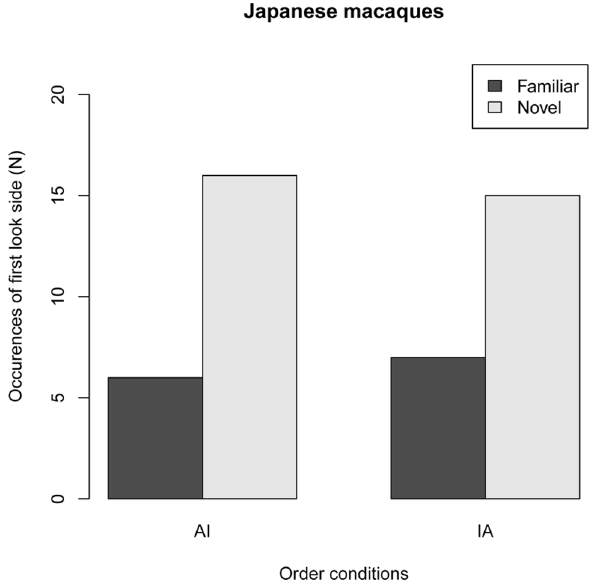
Figure 2. First look sides (FLs) for the stimulus novelty and order conditions in 44 trials of 11 Japanese macaque subjects. In the adult/infant (AI) condition, the adult image was used as the stimulus in the familiar phase and the infant image served as the novel stimulus in the test phase. In the infant/adult (IA) condition, the infant image was used as the stimulus in the familiar phase and the adult imaged served as the novel stimulus in the test phase. Black bars, FLs for familiar stimuli; white bars, FLs for novel stimuli.